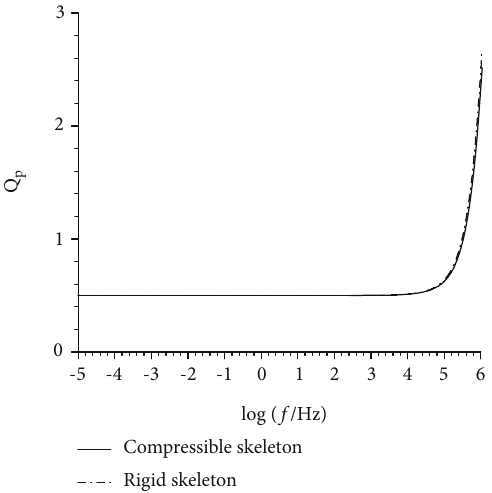
Figure 6: Same as Figure 5 except for the quality factor ( Q